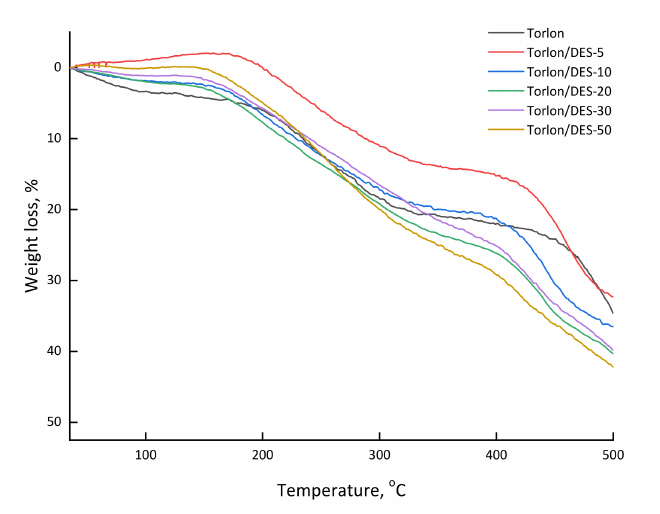
Figure 4. TG curves of pure Torlon and Torlon/DES (5–50%)